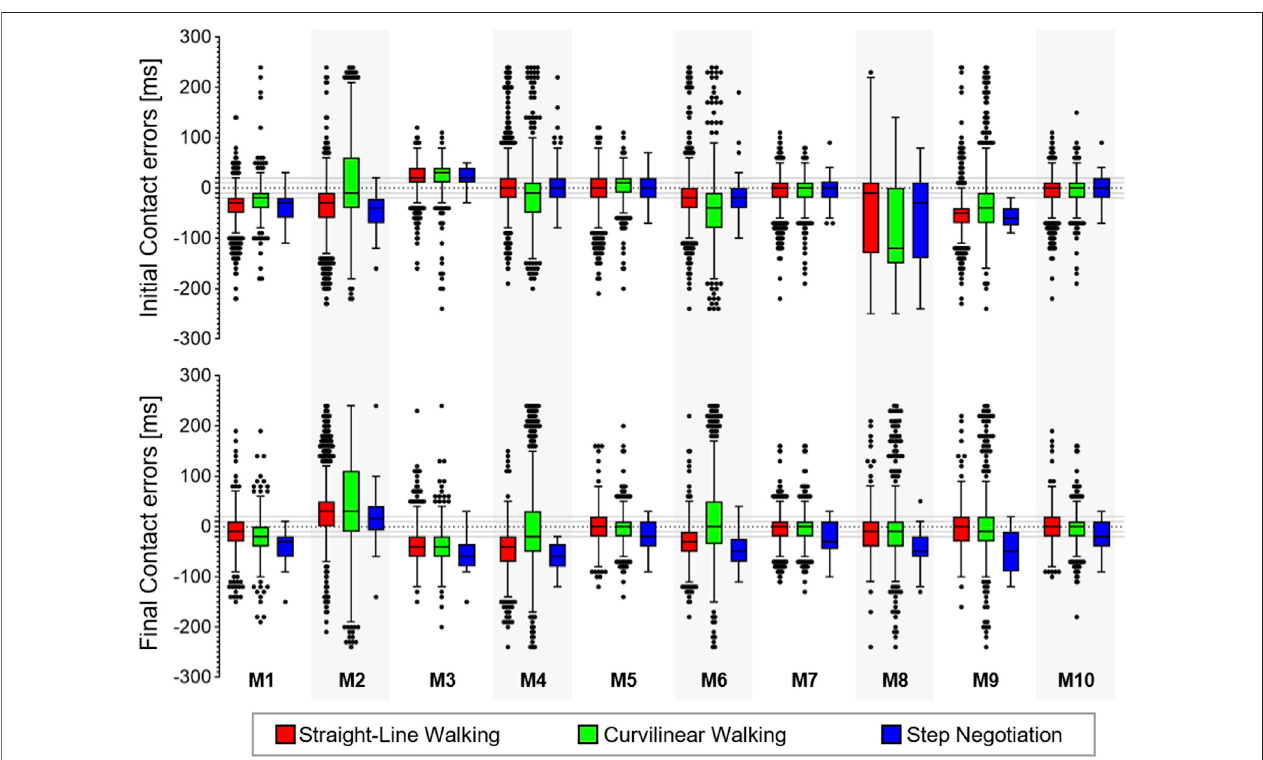
FIGURE2| Box-plots(minimum,lowerquartile,median,upperquartile,andmaximum)oftheerror(ms)forthetruepositive(TP)initialand fi nalcontactsfromthe10 methods (M1, ... , M10) in the young healthy adult cohort in the three walking conditions. Outliers are also shown.